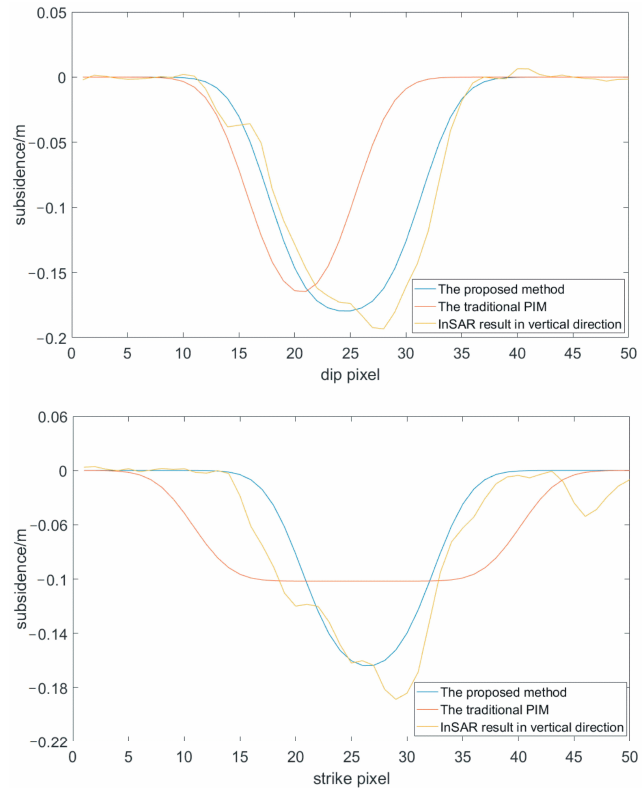
Fig 13 Figure 13. Profiles of the simulated deformation model. The red lines are the profiles of the SBAS- InSAR results. The blue lines are the profiles of the proposed method and the green lines are the profiles of the traditional PIM. They are drawn in strike and dip directions,